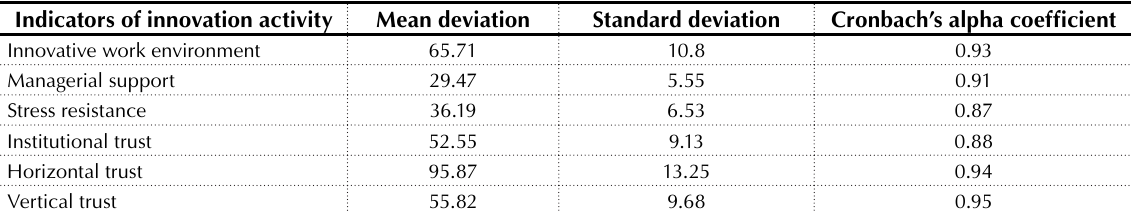
Table 2. Analysis of scales’ reliability. Mean and standard deviation